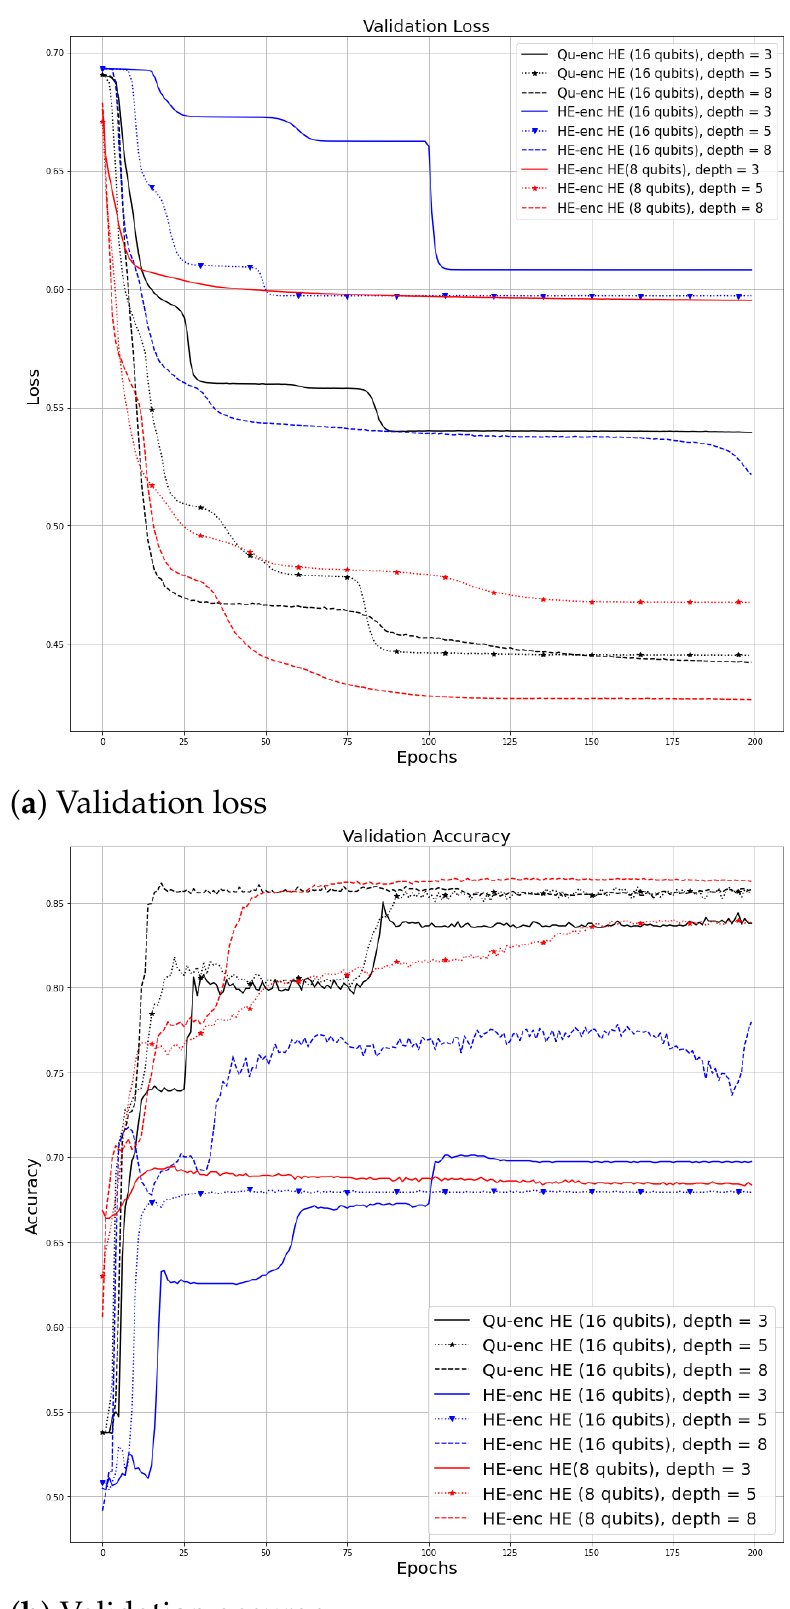
Figure 7. Learning curves in validation of HE circuits